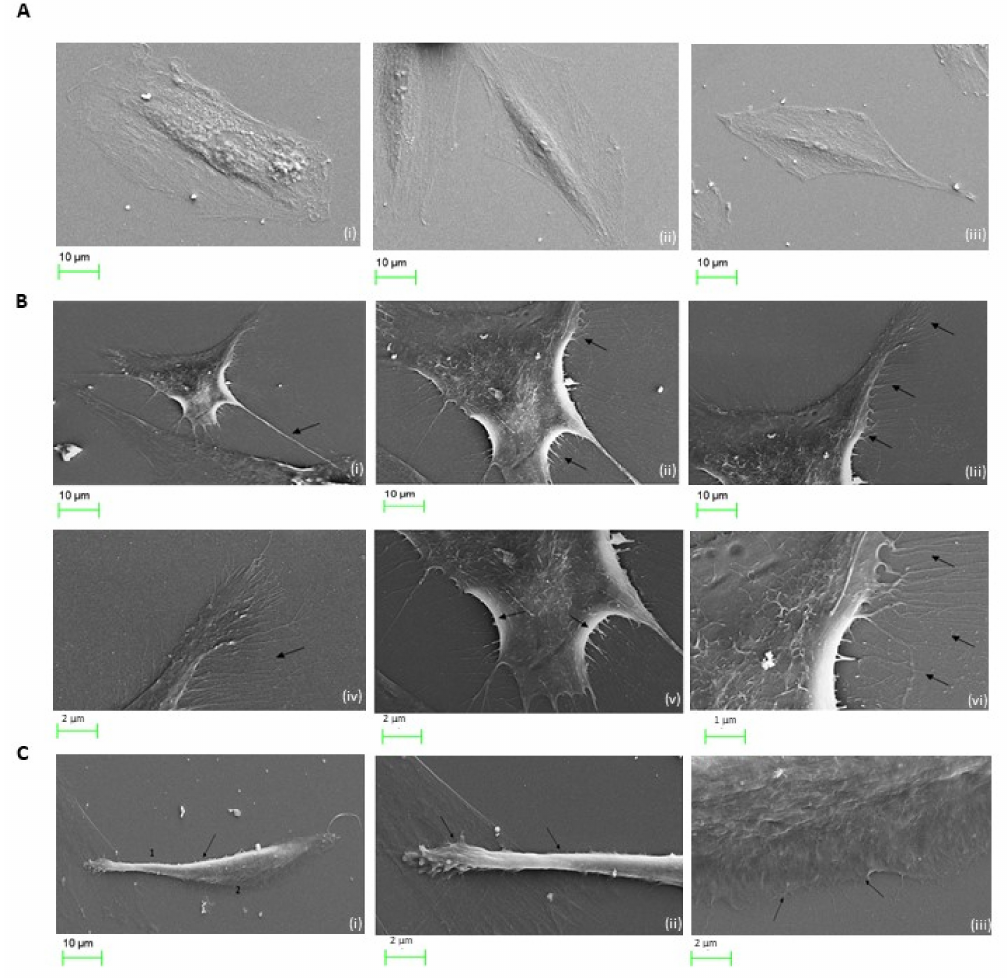
Figure 7. Low dose cocaine treatments result in morphological alterations of H9c-2 cardiomyocytes. ( A ) Untreated H9c2 cardiomyocytes observed under SEM microscopy, normal morphology was retained with intercellular connections and spindle like spreading present at 24 h following culture. Cells display characteristics mono or multi-nucleated spindle to stellate shaped. ( B ) Morphological alterations induced in H9c2 cardiomyocytes following exposure to 1 µ g/mL cocaine. Cocaine induced formation of thick and finer membrane extension (i–iv and F–H, arrows, respectively) and folding V arrows). ( C ) Membrane protrusions and cellular attachments in H9c2 cardiomyocytes treated with 1 µ g/mL cocaine. H9c2 cardiomyocytes indicated features of altered microstructural architecture, with membrane polarisation (i and ii, arrows), cell-substrate adhesion and retraction observed posterior to sites of membrane folding observed in (i) (iii, arrows). Scale bar for each panel are presented below the respective image with numerical assignment indicating feature specific